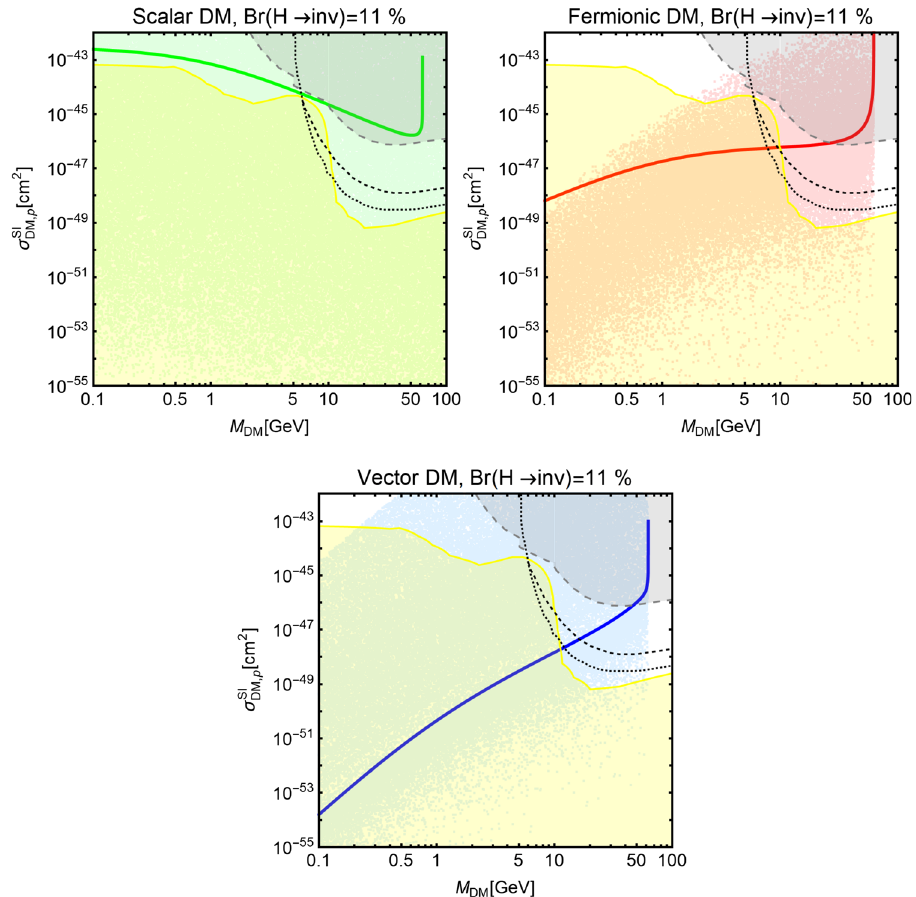
Fig. 4 Same as in Fig. 3 considering in addition the case of a light H 2 boson. The three panels are for the scalar, fermionic and vector DM cases. Only the BR ( H 1 → inv ) = 0 . 11 is displayed this